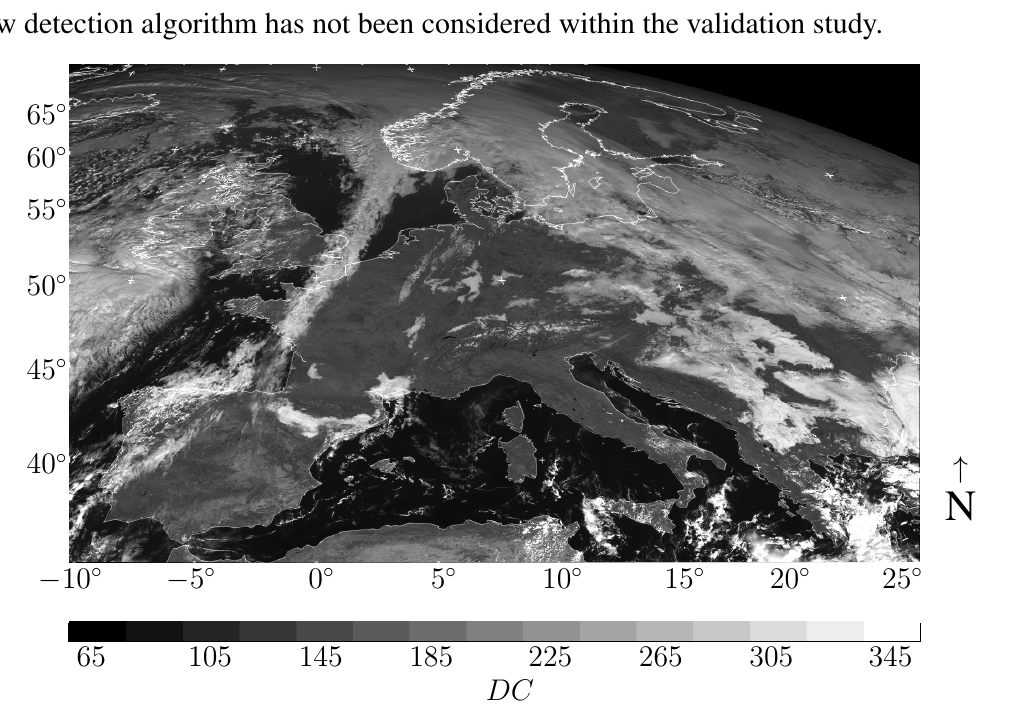
image for Europe, 1 November 2014, 0300 10 . 8